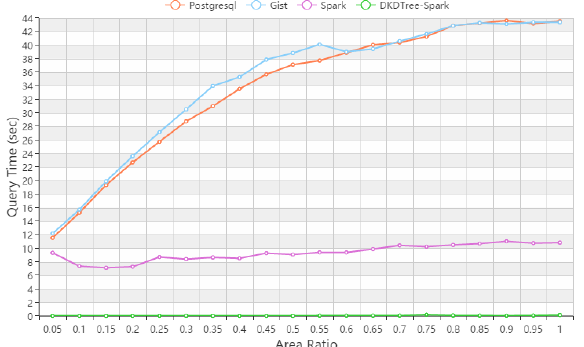
Fig ure 6 . Paging Query in Different Sizes of the Query Polygon 4.2.3 Counting Query in Different Number of CPU: In